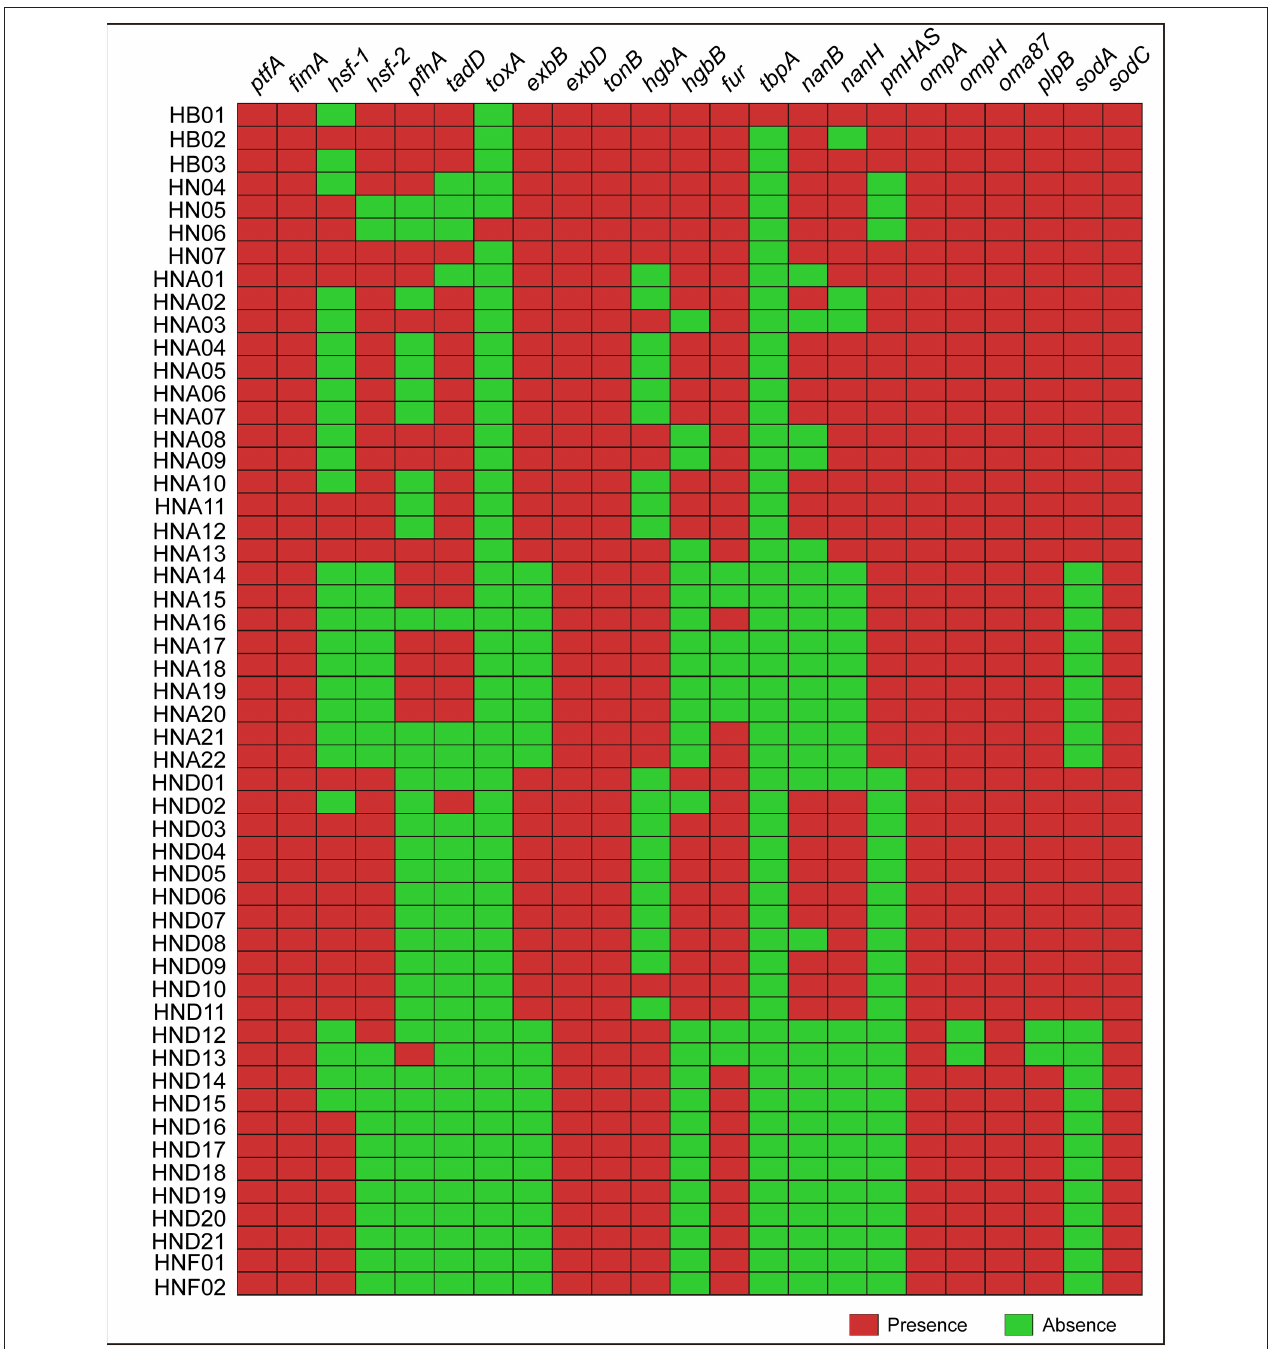
FIGURE 2 | Heatmap showing the distribution of the 23 types of virulence genes (VFGs) among the 52 P. multocida strains from pigs. Boxes in red indicate a VFG is presence in the strain while boxes in green represent a VFG is missing in the